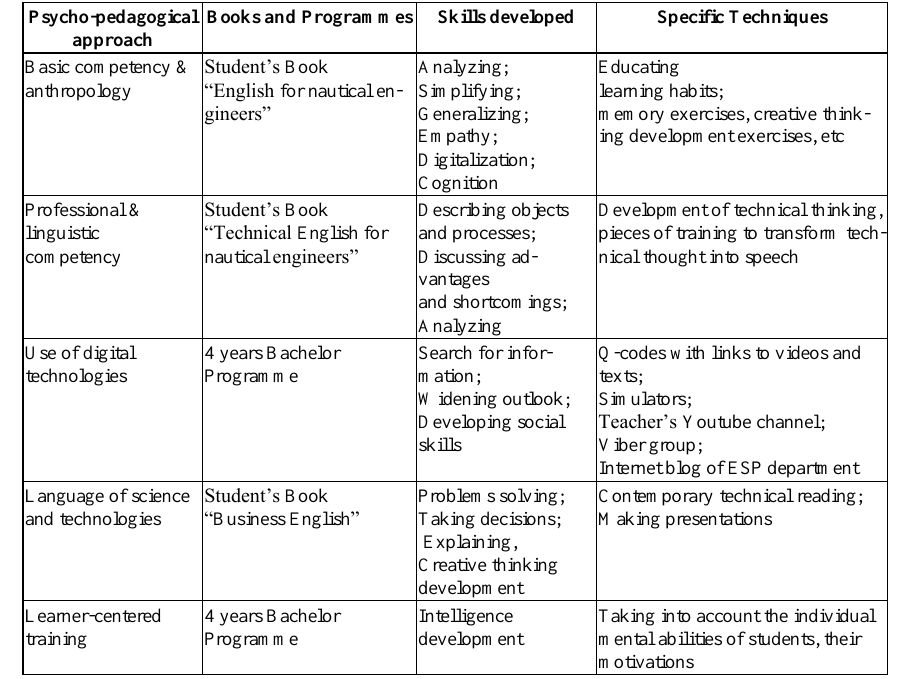
Table 2. Approaches in the design of instructional